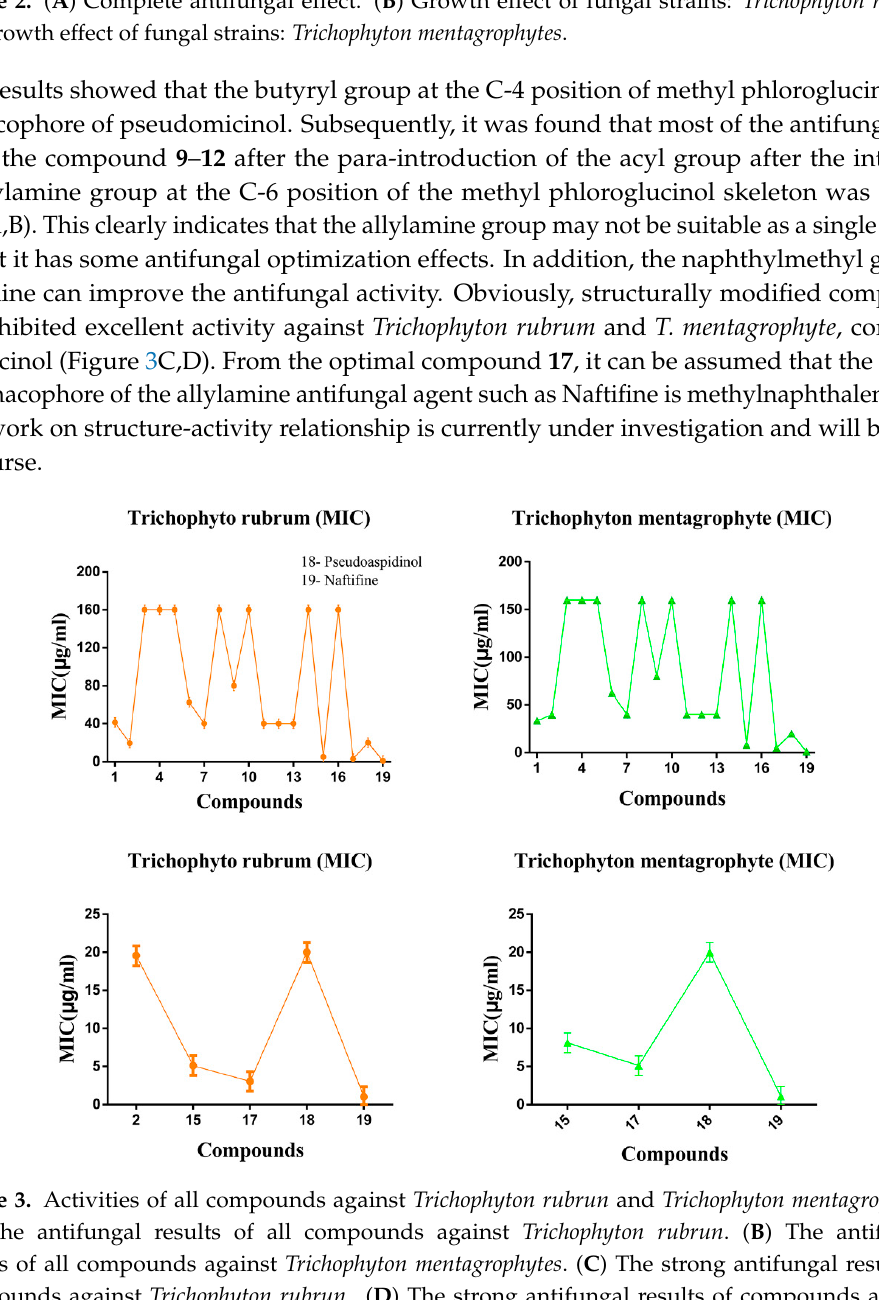
Figure 3. Activities of all compounds against Trichophyton rubrun and Trichophyton mentagrophytes . ( A ) The antifungal results of all compounds against Trichophyton rubrun . ( B ) The antifungal results of all compounds against Trichophyton mentagrophytes . ( C ) The strong antifungal results of compounds against Trichophyton rubrun . ( D ) The strong antifungal results of compounds against Trichophyton mentagrophytes